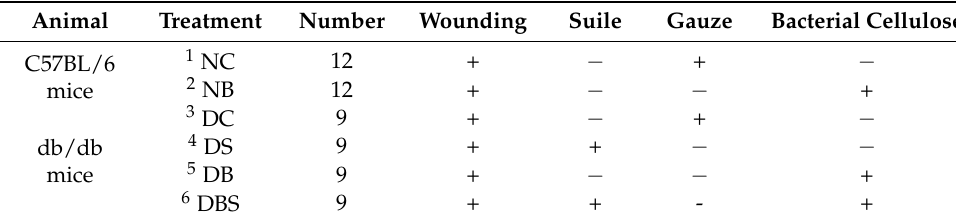
Table 2. Animal treatment and numbers in this